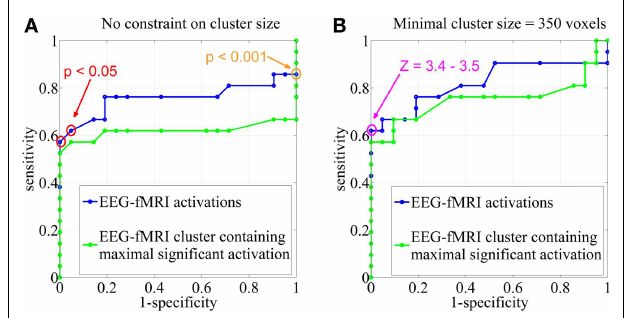
FIGURE 3 | Sensitivity and specificity . Receiver operating characteristic (ROC)-curves using different statistical Z -score thresholds at the voxel level (range, 0–13; step-size, 0.1) and (A) no constraint on cluster size, (B) a minimal cluster extent of 350 voxels.The results were based on all EEG-fMRI activations (blue) and upon the cluster containing the maximal significant activation only (green).The orange circle corresponds to the statistical threshold of uncorrected p < 0.001 ( Z = 3.1), red circles to a significance level of FWE corrected p < 0.05 ( Z = 4.9–5.1).The pink circle represents Z -score thresholds of 3.4 and 3.5. Note that not every change in Z -score threshold is associated with a change in sensitivity and specificity.